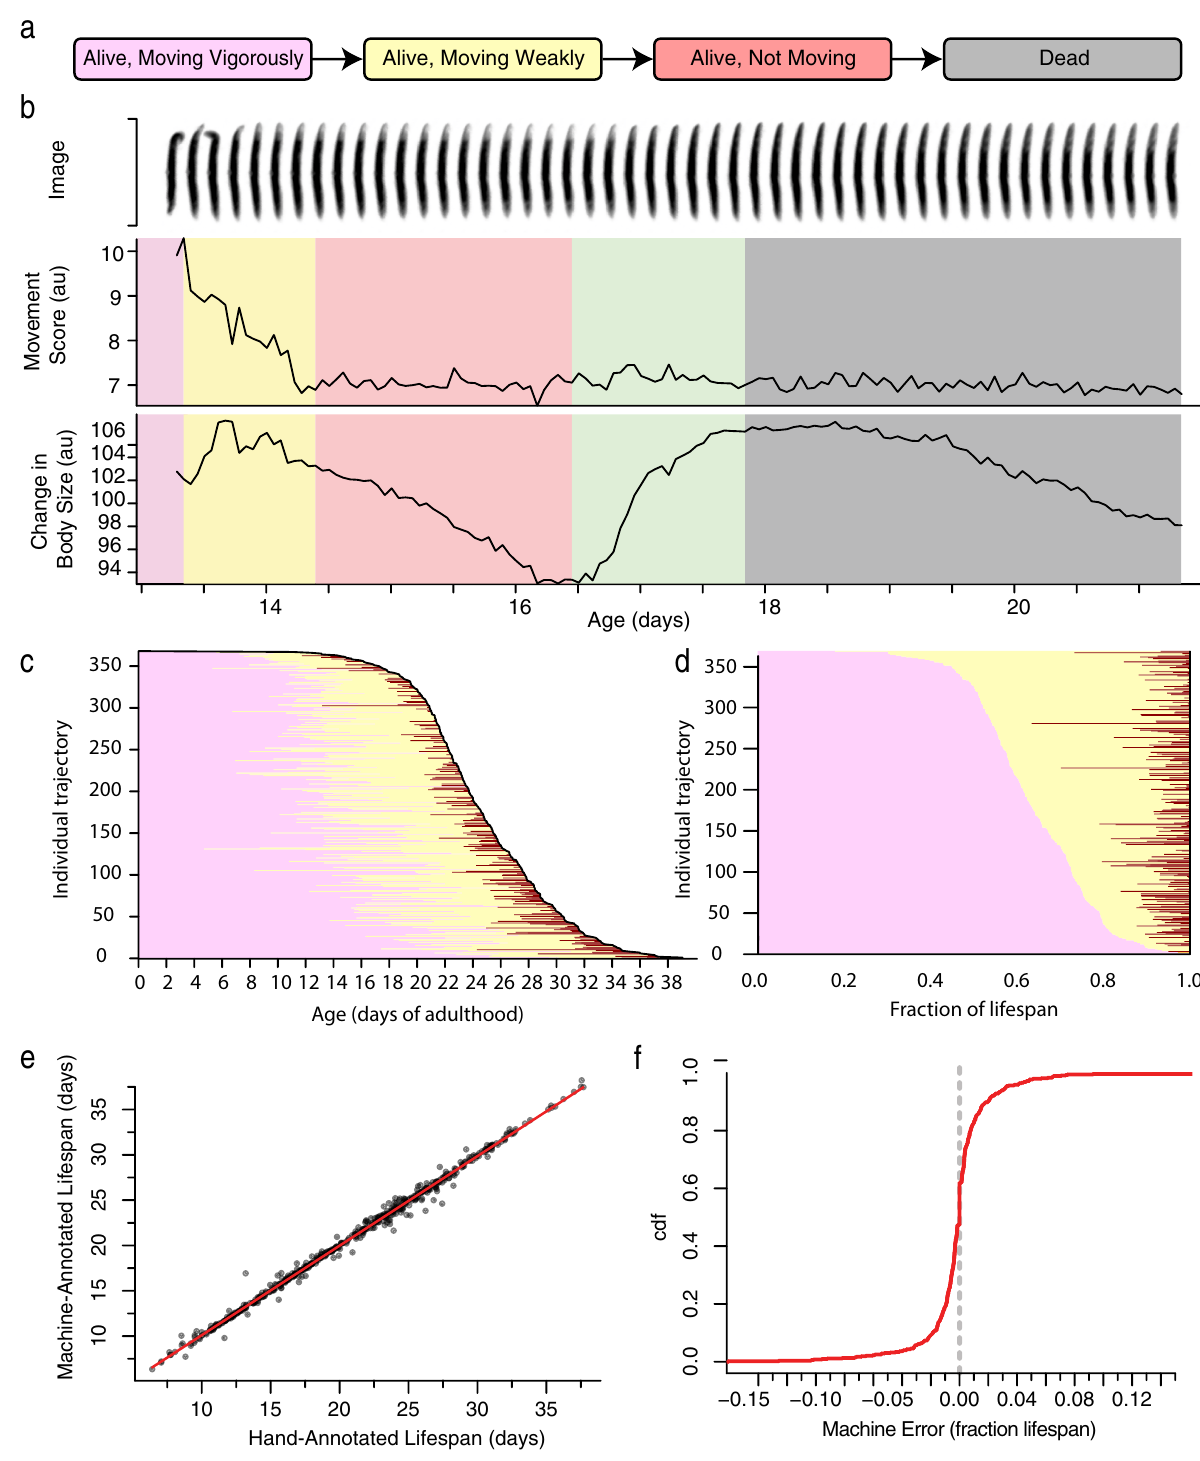
Fig 1. Automated, high-throughput phenotyping. a. A coarse classification scheme for behavioral aging and death involving four states. b. The last few days of an individual’s life involve a set of stereotyped movement and morphological transitions. After a week or more of vigorous movement (purple), individuals slow down and exhibit only weak postural changes (yellow) until eventually ceasing all movement (red). Meanwhile, their apparent body size decreases until the time of death at which point it increases rapidly (green), plateaus, and then decreases again (gray). c. In a population of 368 wild- type animals, the times spent moving vigorously (pink), moving weakly (yellow), and non-moving (red), were annotated by hand and plotted.